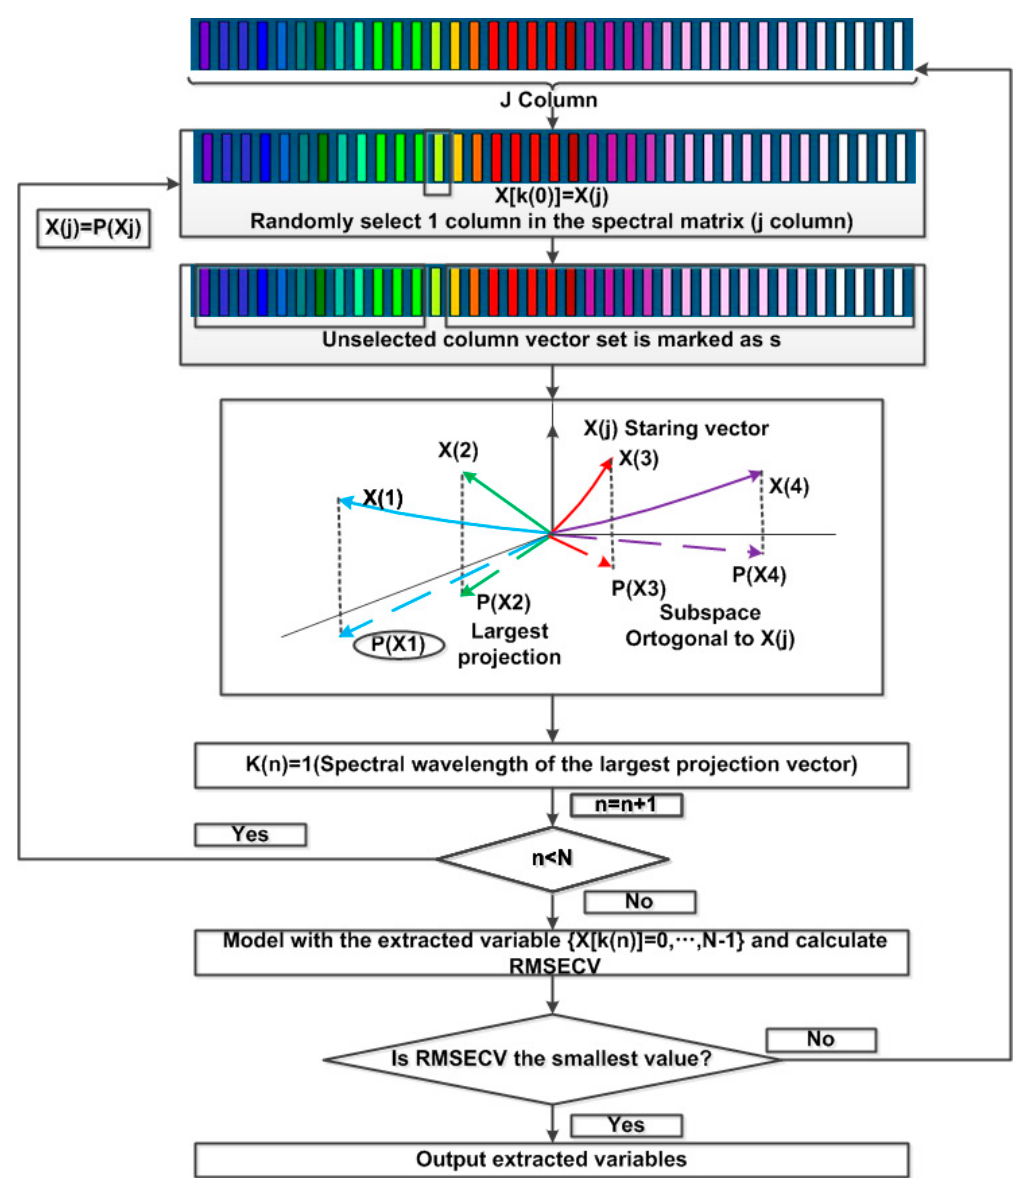
Figure 4. Successive Projections Algorithm (SPA) schematic; the SPA includes two phases. At first, the algorithm builds candidate subsets of variables on the basis of a collinearity minimization criterion. Such subsets are built according to a sequence of vector projection operations applied to the columns of the matrix of available predictor data. In the second phase, the best candidate subset is chosen, based on Root Mean Squares Error Cross Validation (RMSECV) obtained in a validation set [27].